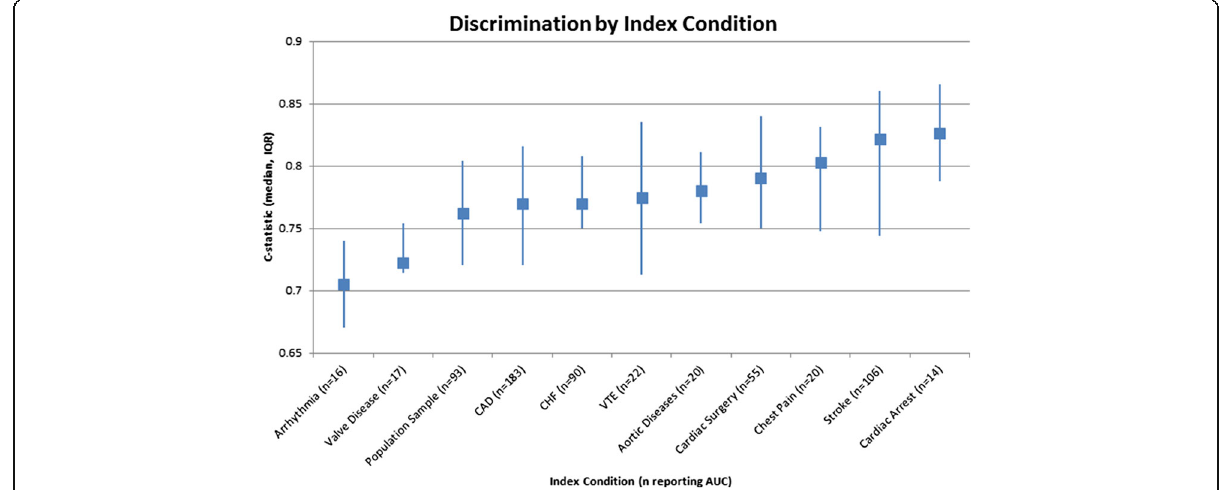
Fig. 4 Discrimination of CPMs by index condition. Discrimination is reported as c -statistic (median, IQR). CPM, clinical prediction model; CAD, coronary artery disease; CHF, congestive heart failure; VTE, venous